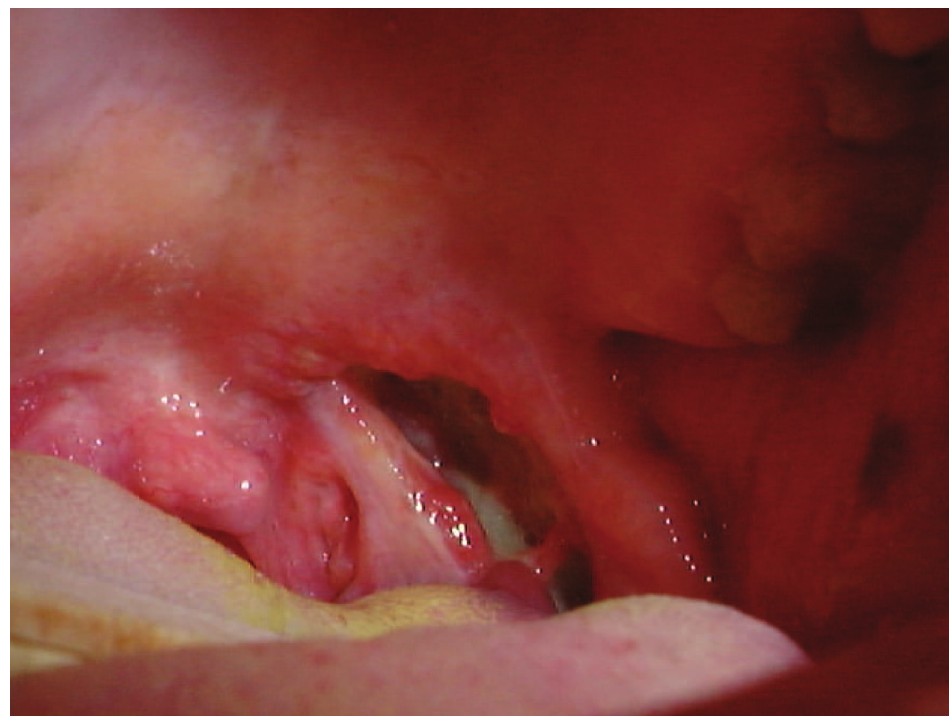
Figure 1 - Bacterial tonsillitis and abscess.